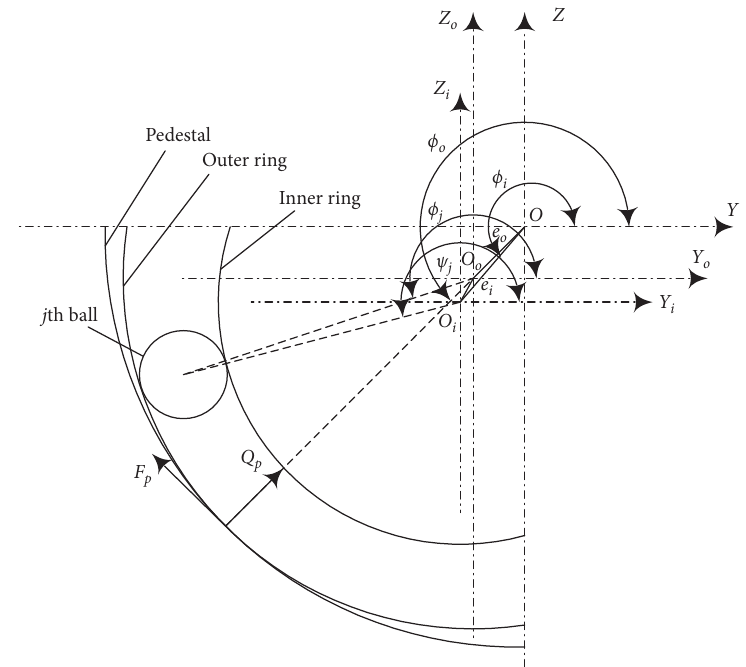
Figure 3: Contact between the outer ring and the pedestal.